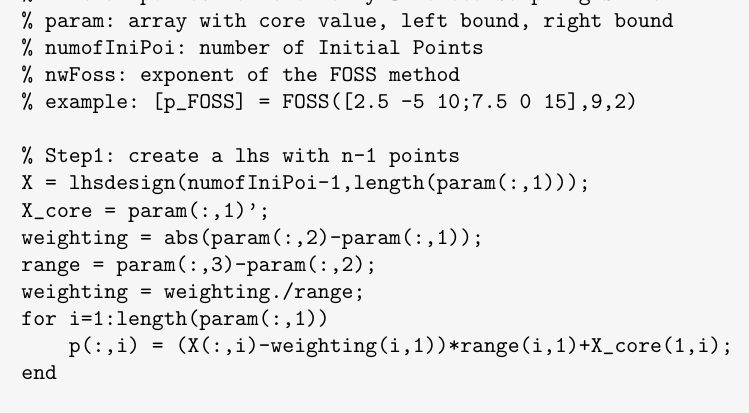
Fig. 4 Coding of the FOSS method in the environment of MATLAB